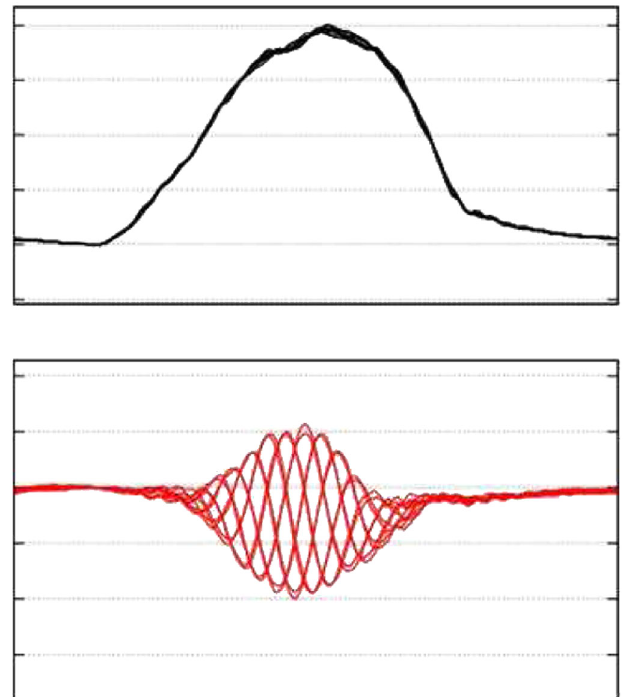
FIG. 11. (Color) The centroid oscillations in head-tail instability induced in the RCS ring. Upper: the sum of BPM signals; bottom: the difference of the BPM